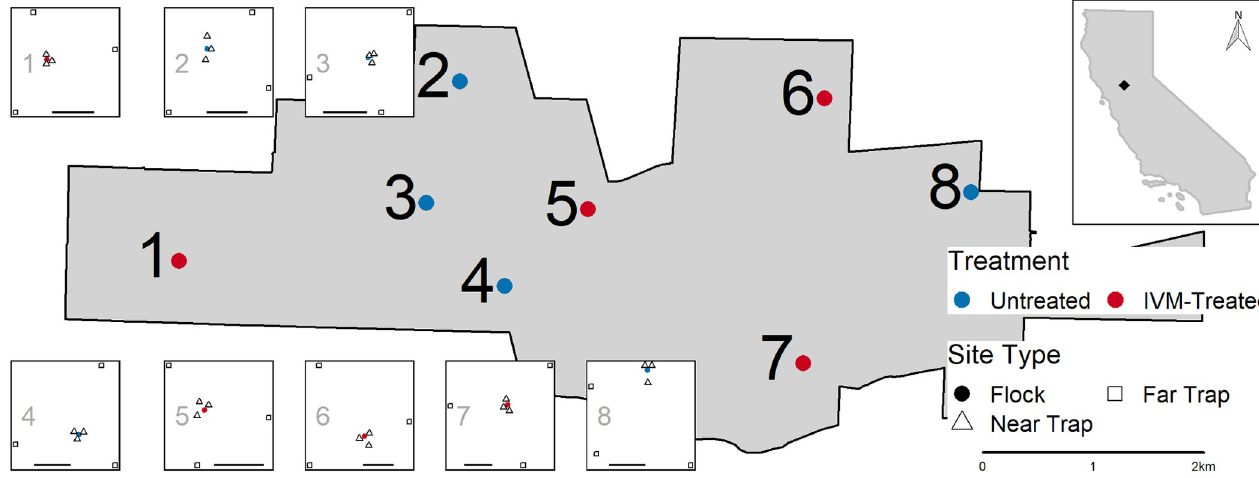
Fig 1. Location of ivermectin (IVM)-treated (red) and untreated (blue) chicken flocks and CO2-baited mosquito traps in Davis, California. Numbered insets illustrate the arrangement of dry-ice baited CO2-traps around each flock, with three traps within 10m (triangle) and three traps approximately 150m from the flock (square). Bar in each inset indicates 100m. Top right inset illustrates the location of the study site in relation to the state of California. Geographic boundaries for the state of California and the city of Davis were obtained from the 2020 TIGER/Line shapefiles for States and Places, respectively, provided by the United States Census Bureau (https://www.census.gov/cgi-bin/geo/shapefiles/index.php).